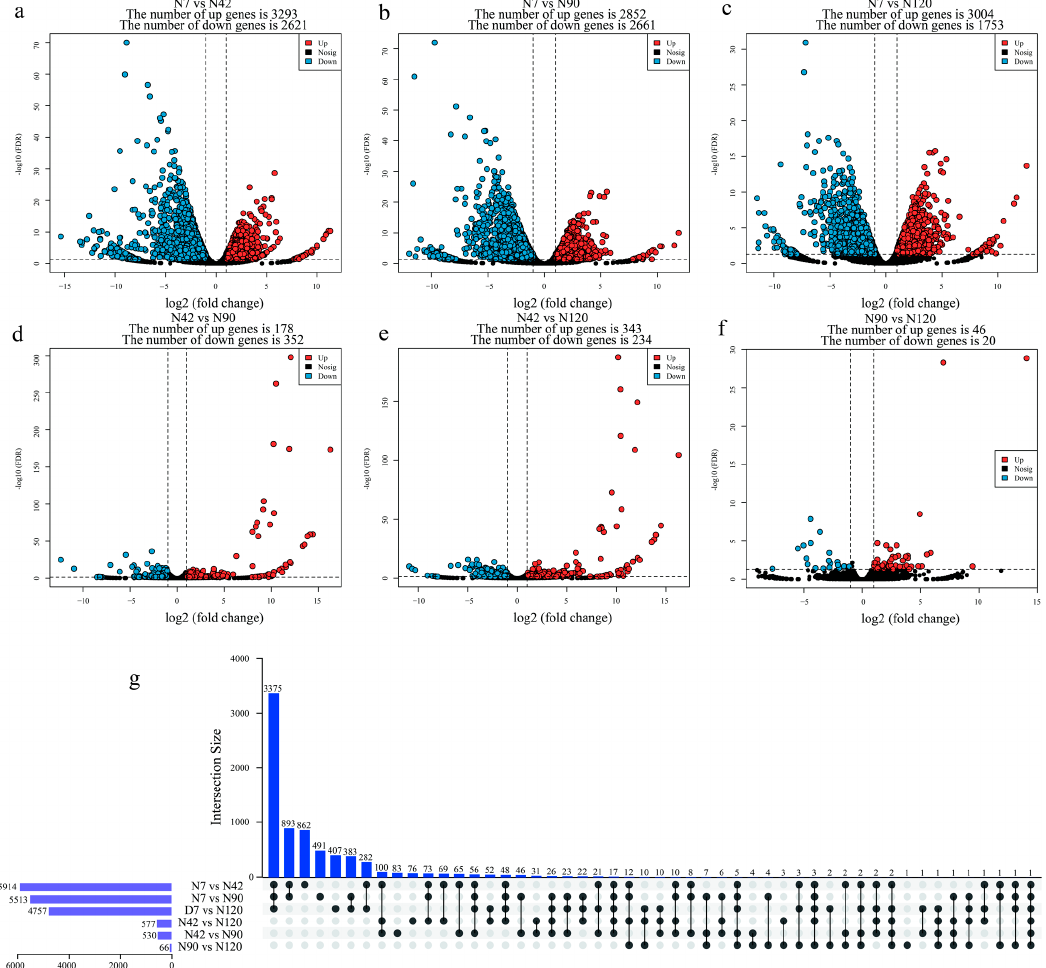
Figure 2. Volcano plot of differentially expressed genes (DEG) identified by comparison groups. ( a ) D7 vs. D42; ( b ) D7 vs. D90, ( c ) D7 vs. D120, ( d ) D42 vs. D90, ( e ) D42 vs. D120, and ( f ) D90 vs. D120. “Up” and “Down” indicate that the expression levels of the DEGs were significantly (FDR p < 0.05 and |log2FoldChange| > 1) higher and lower in the different comparison groups, respectively. “Nosig” indicates that the expression levels of the genes are not significantly different in the differ- ent comparison groups; ( g ) UpSet plot of the differentially expressed genes (DEGs) of RNA-Seq.